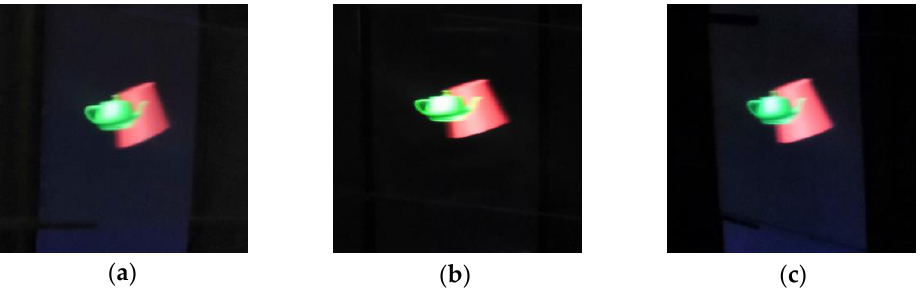
Figure 9. 3D images captured at ( a ) − 45°, ( b ) 0°, and ( c ) 45° viewing angles.